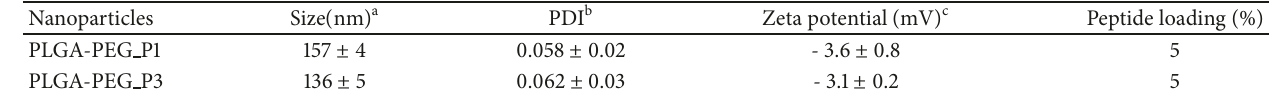
Figure 1: Immunoblotting analyses with an L-plastin (LPL) and a p-Serine antibody. (a) Analysis of time-dependent expression of LPL in osteoclasts treated with (+; lanes 2-5) and without (-; lane 1) bone particles in the presence of TNF- 𝛼 . (a) Immunoblotting analysis with an antibody to LPL (top panel) and GAPDH (bottom panel). (b) Amino acid sequences of TAT (11aa) -fused sNT-LPL (10aa) and control TAT alone (11aa) peptides are shown: P1) unsubstituted (S5S7); P2) double substituted (S5S7 to A5A7); P3) scrambled; P4) control TAT sequences only. (c). Immunoprecipitation and immunoblotting analyses. The effect of indicated sNT-LPL peptides (P1 to P4) on the phosphorylation of endogenous LPL is shown. An equal amount of osteoclast lysates was immunoprecipitated with an antibody to LPL and subjected to immunoblotting (IB) with a p-Serine antibody (top). This blot was stripped and blotted with an LPL antibody (panel (c); middle). Immunoprecipitation of lysates made from P2-transduced cells with a species-specific nonimmune serum was used as a control for immunoprecipitation(lane5).Anequal amountof total protein(Input)used for immunoprecipitationwas assessedby directimmunoblotting of lysates with a GAPDH antibody. The experiment was repeated thrice and obtained comparable inhibitory effect with P1. Table 1: Physicochemical characterization of